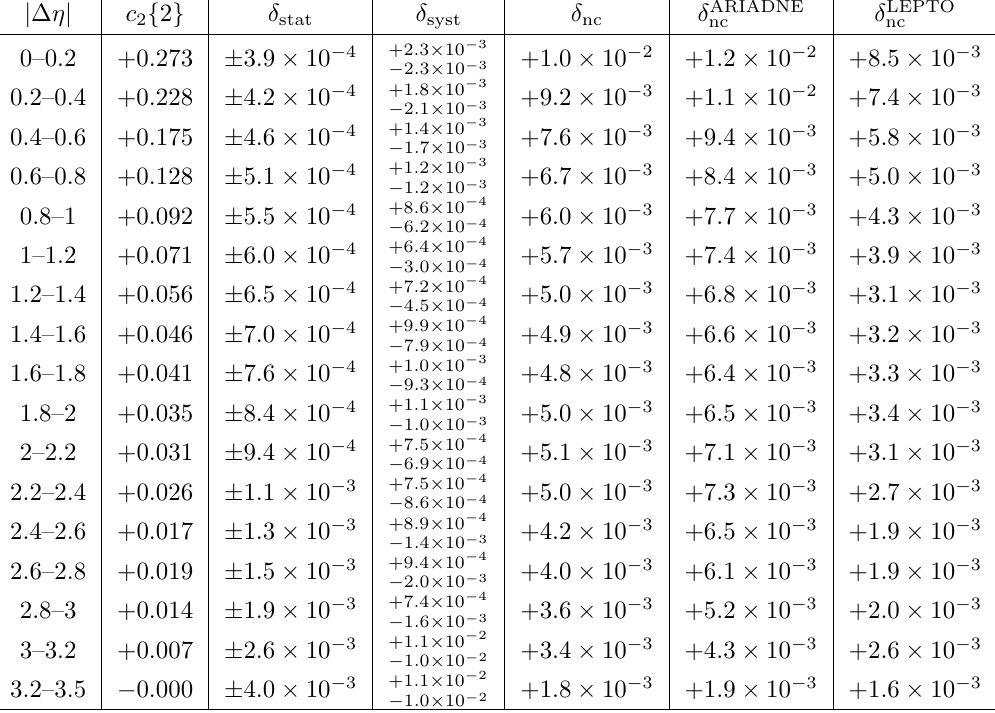
Table 16 . c 2 f 2 g versus j (cid:1) (cid:17) j from (cid:12)gure 8 (b) and (cid:12)gure 12 (c), p T > 0 : 5 GeV; (cid:14) stat , (cid:14) syst and (cid:14) nc denote the statistical, systematic and Monte Carlo non-closure uncertainties,